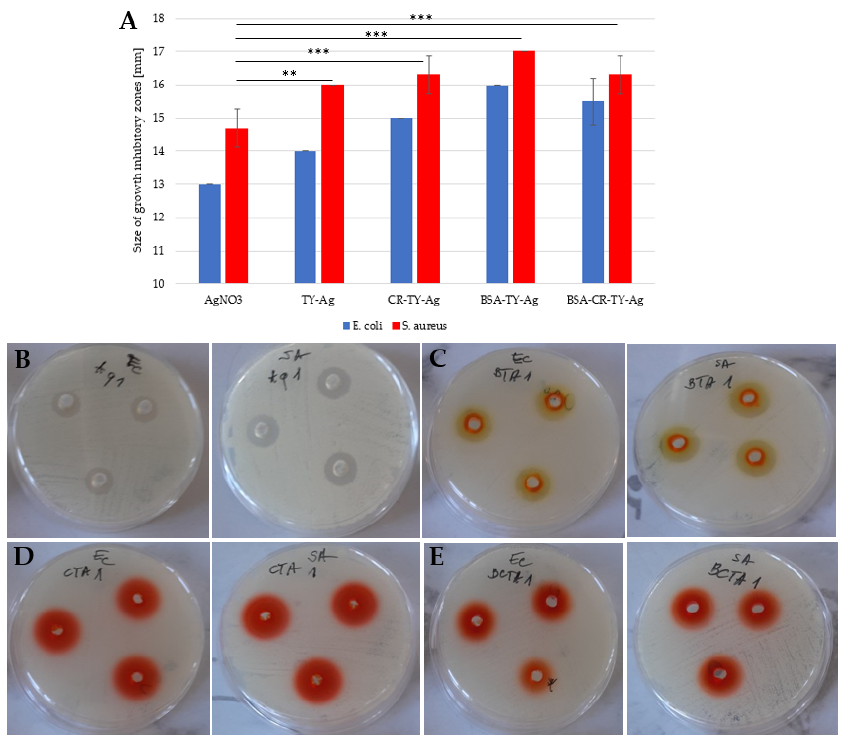
Figure 11. ( A ): A histogram presenting a comparison of the size of growth inhibitory zones of two strains: Escherichia coli ( E. coli )and Streptococcus aureus after adding the silver complexed with: TY, CR-TY, BSA-TY and BSA-CR-TY; growth inhibitory zones on plates from left to right for E. coli and for S. aureus (each probe in triplicate) after adding: ( B ): AgNO 3 ; ( C ): BSA-TY-Ag; ( D ): CR-TY-Ag, and ( E ): BSA-CR-TY-Ag (each probe in triplicate); concentration of silver in each probe: 4.7 mM. The analyzed using the Student’s T -test. Statistically significant differences (** p < 0.01; *** p < 0.001) in the silver complexes were